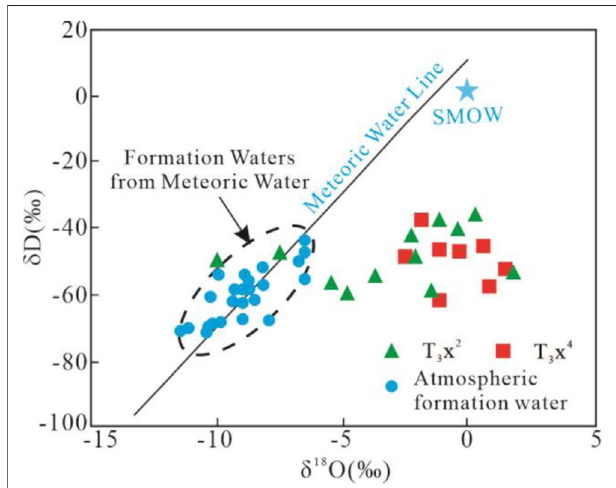
FIGURE 7 | Hydrogen and oxygen isotope characteristics of the formation water and atmospheric precipitation in the Xujiahe Formation in the middle part of the western Sichuan